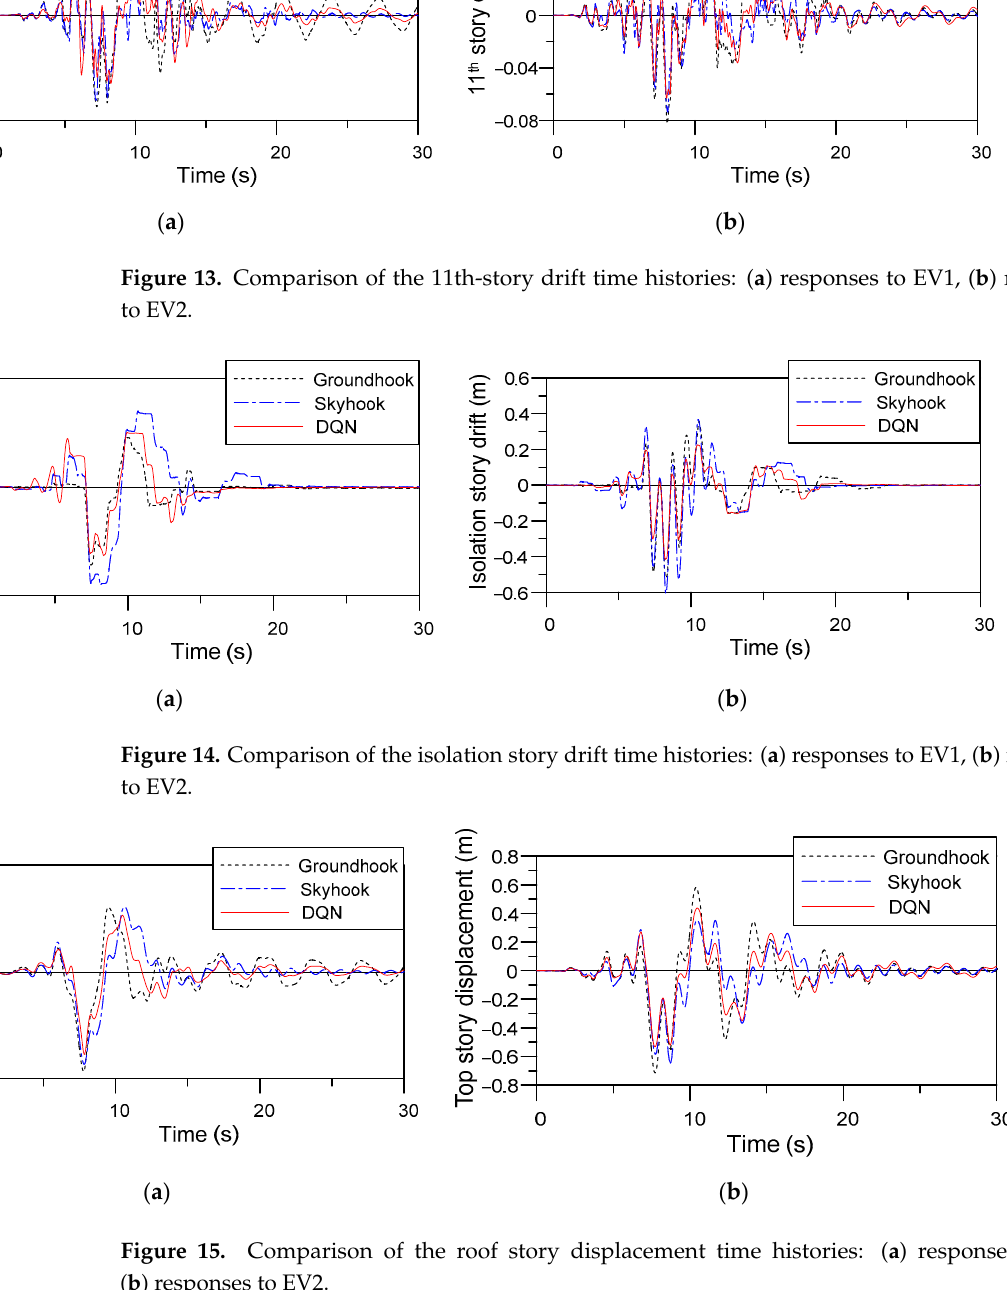
( b ) Figure 15. Comparison of the roof story displacement time histories: ( a ) responses to EV1, ( b ) re- sponses to EV2.